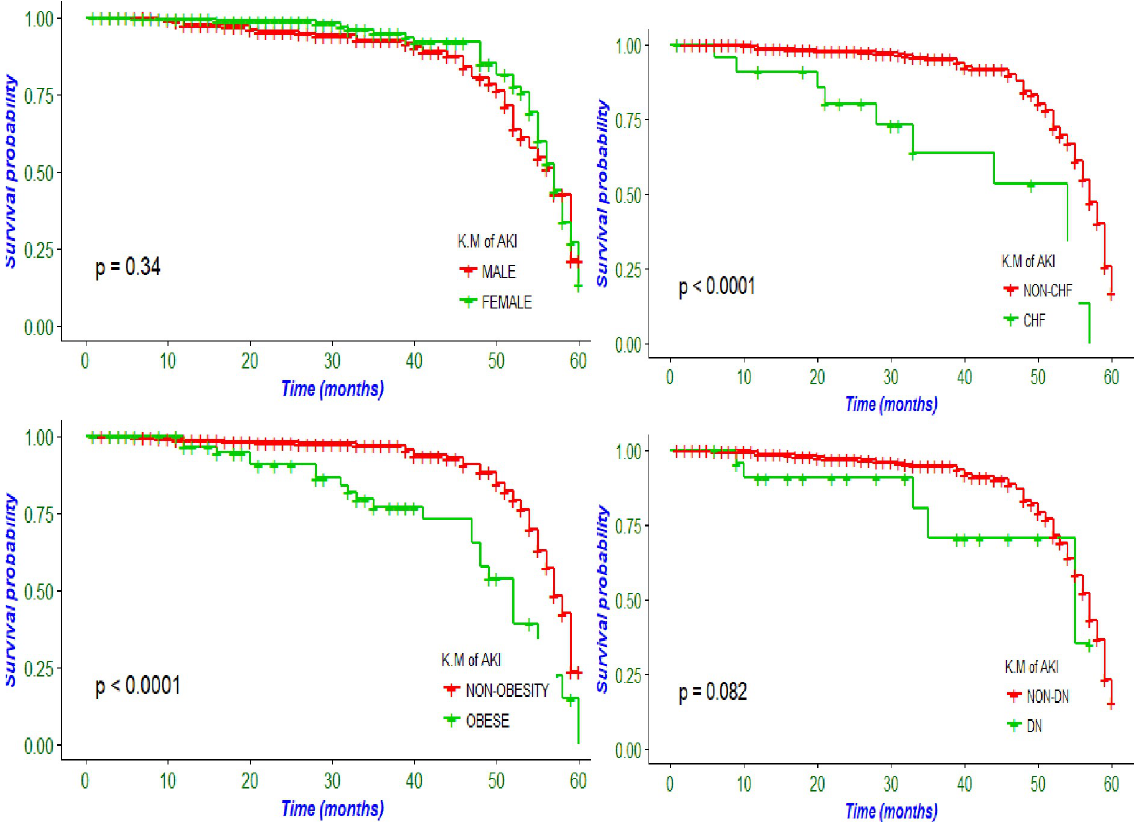
Fig 2. AKI incidence by selected variables among T2D patients in East Ethiopia, from 2013 to 2017.